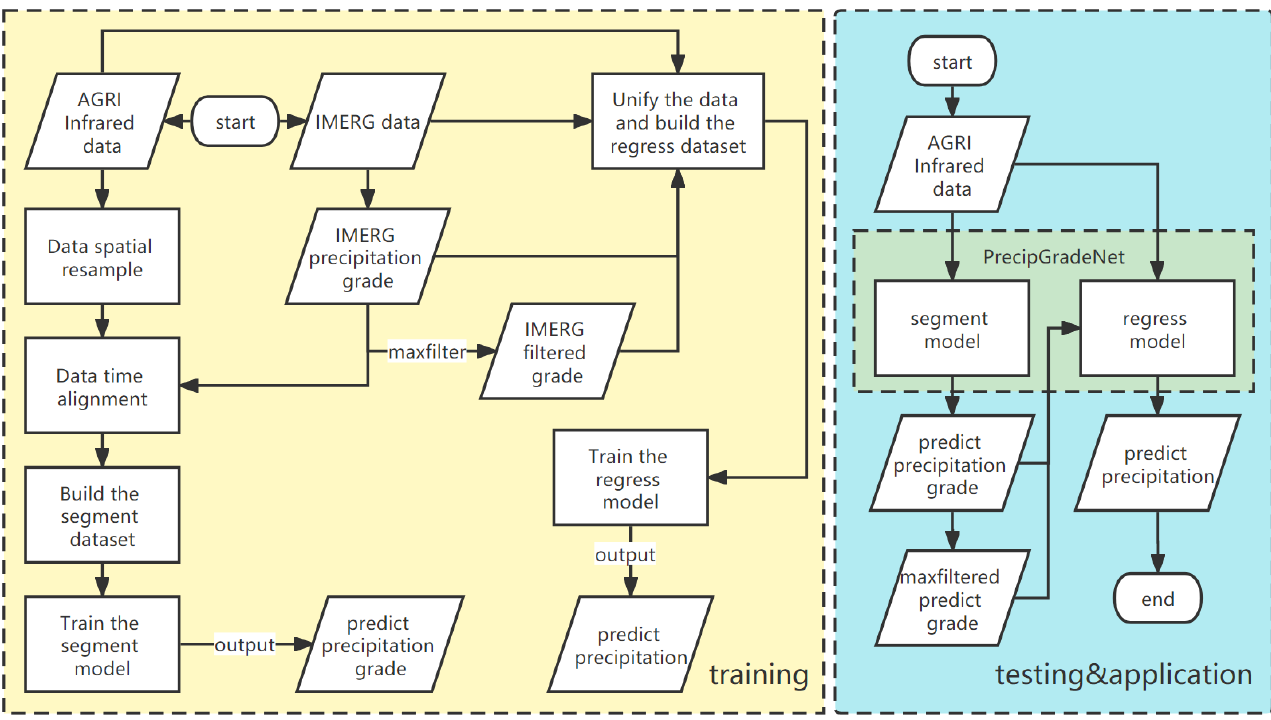
Figure 2. Flow chart of the method.